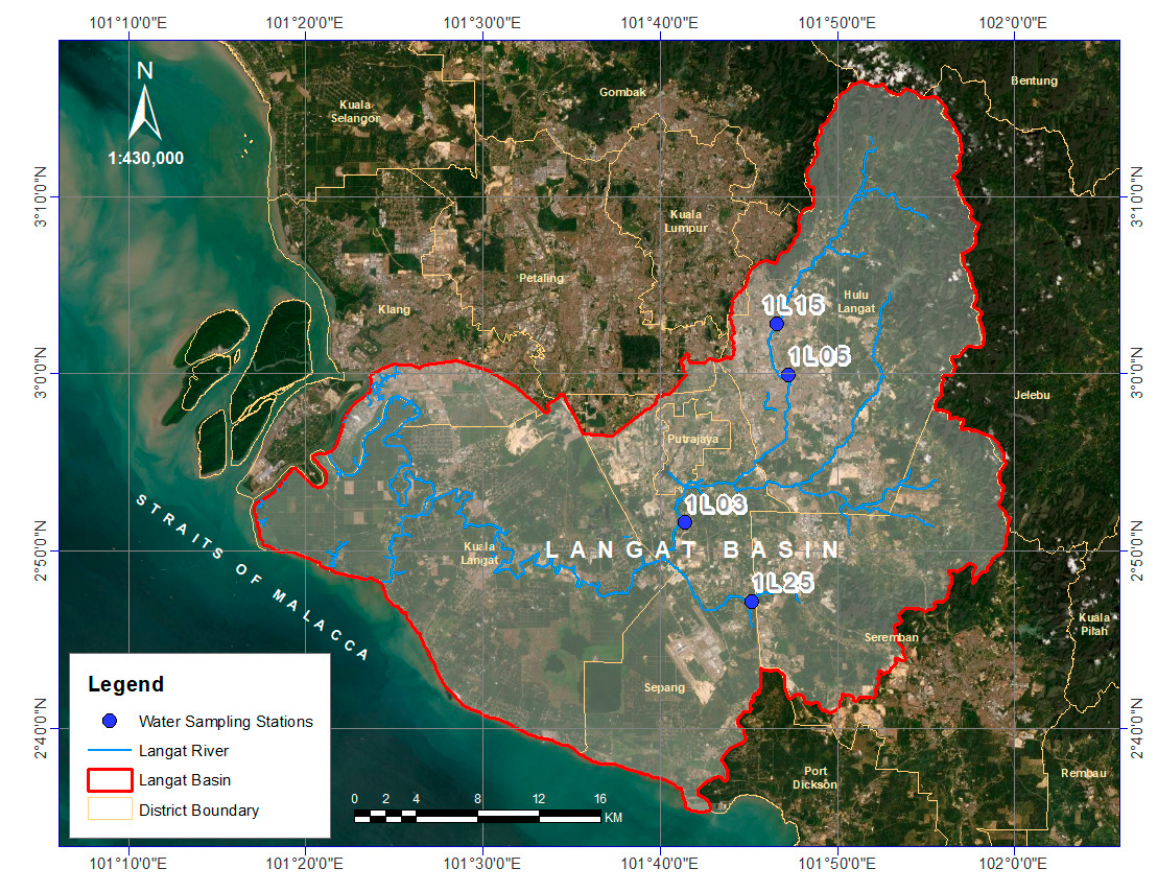
Figure 1. Water sampling stations at the Langat River Basin, Malaysia. Table 2. One-sample t -test on monthly As ( µ g/L) concentrations and physico-chemical parameters at the water sampling stations in Langat River during